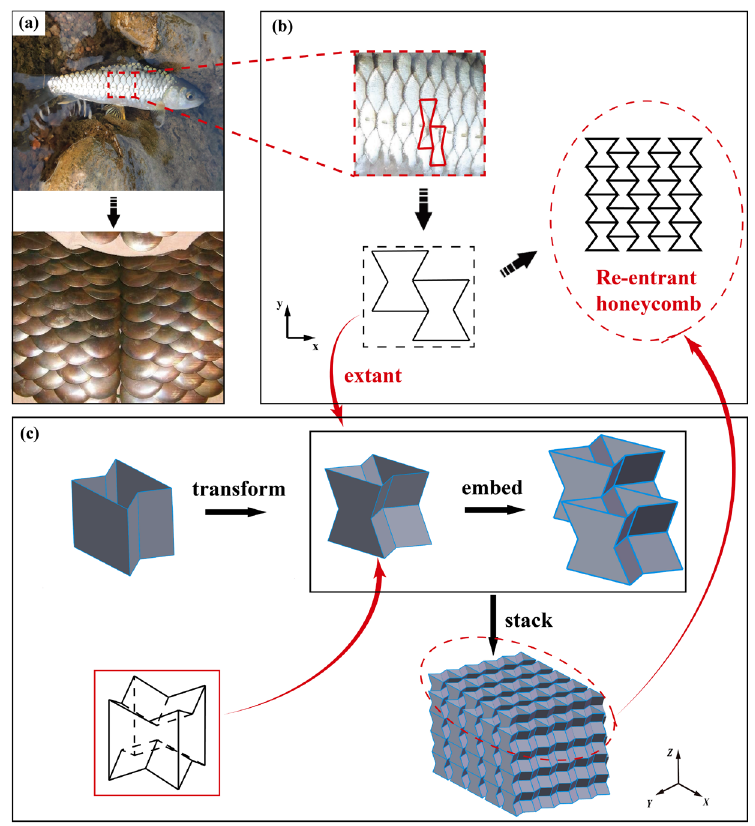
Figure 1. Re-entrant honeycomb unit cell design. ( a ) fish scale armor; ( b ) 2D re-entrant honeycomb; ( c ) 3D re-entrant honeycomb.